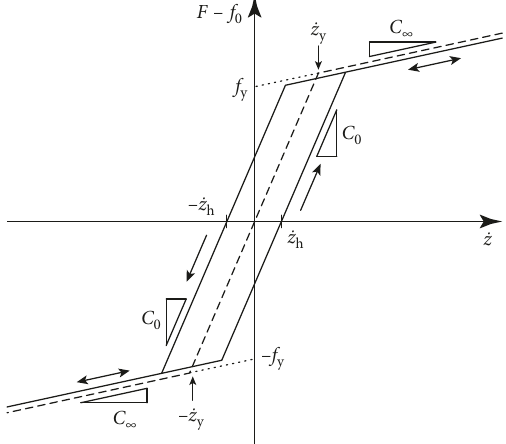
Figure 4: Main MR model